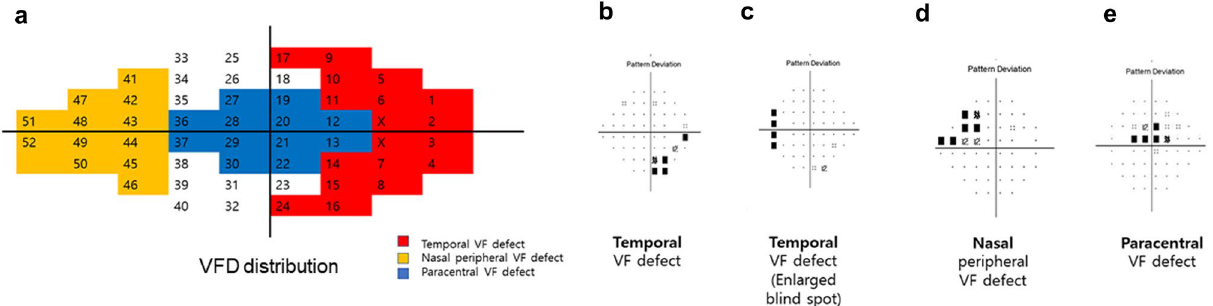
Figure 4. Visual Field Defect (VFD) regions. The distribution of the VFD regions is shown on ( a ). Blue region stands for paracentral VFD, while red region is classified as temporal VFD. Rest regions fall into the category for peripheral VFD. X regions corresponds to the blind spots. ( b ) and ( c ) show examples of the temporal VFD, while ( d ) and ( e ) describe nasal peripheral VFD, and paracentral VFD,